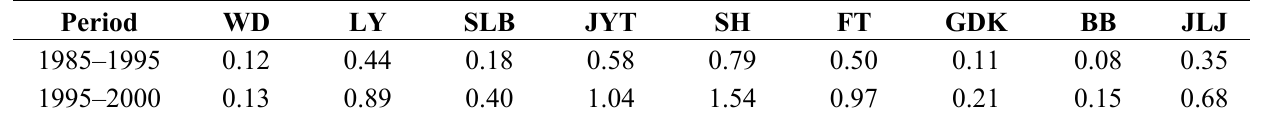
Table 8. Comprehensive dynamic degrees of land use